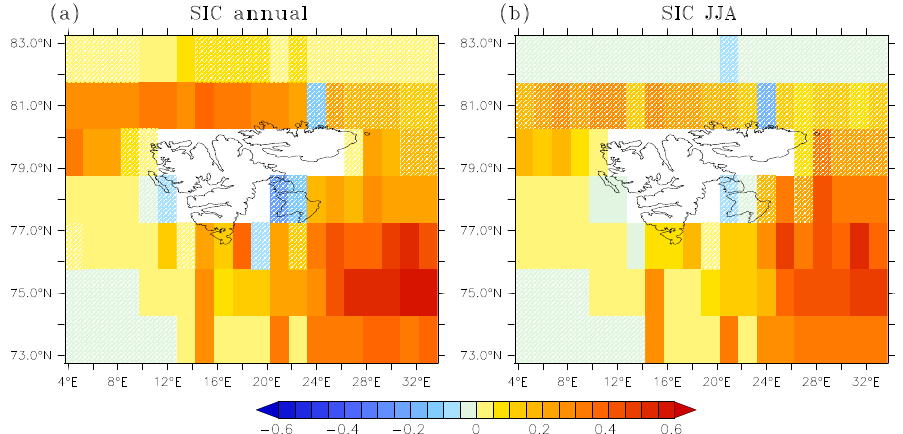
Figure 11. (a) Annual sea-ice cover (SIC) difference between MIROC5 and ERA over 1980–2005. The SIC go from zero to one according to the portion of the oceanic pixel covered in sea ice (0 = ice-free pixel, 1 = pixel completely covered with sea ice). (b) Same as (a) but in summer (JJA). The non-hatched areas correspond to the areas for which the difference is significant at the 95% confidence level.